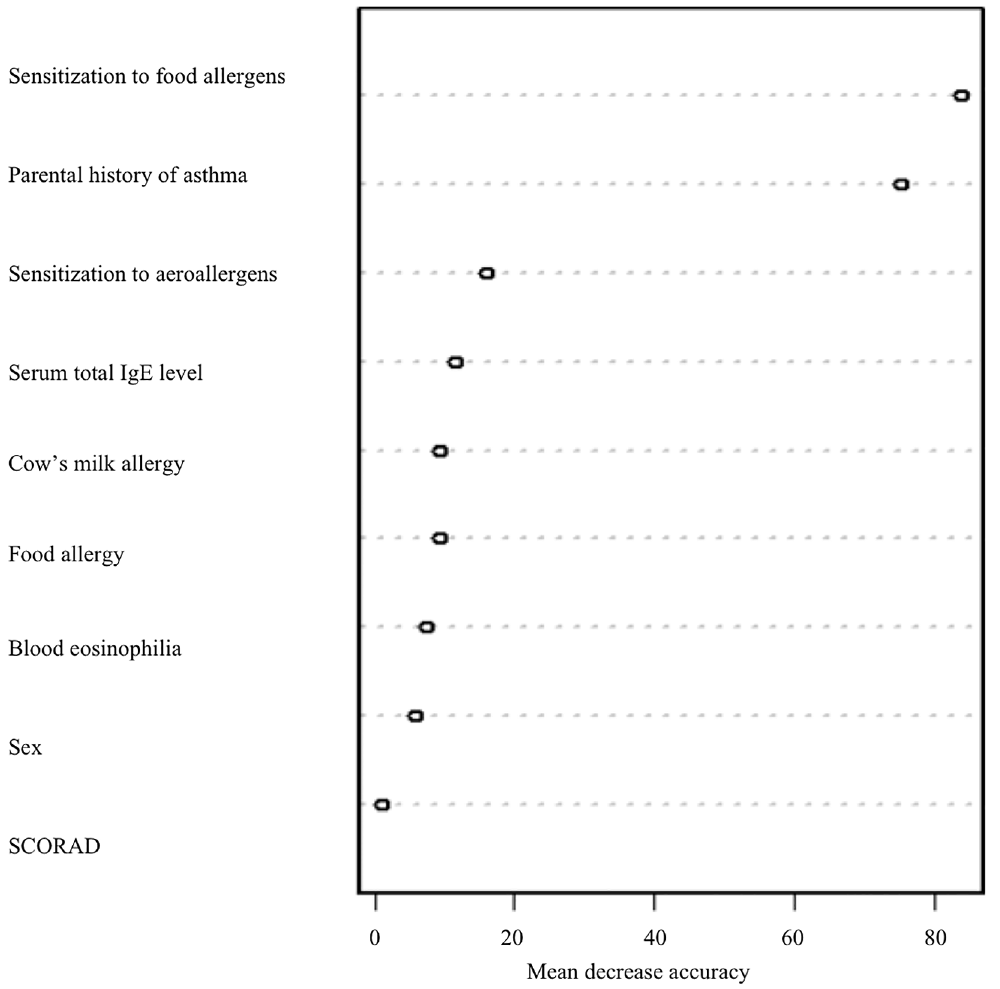
Fig 3. Importance measure (permutation-based mean decrease accuracy) provided by the random forest analysis. The values are not interpretable but the ranking is of interest since a high value of the importance measure is associated with a high predictive power. Sensitization is defined by specific IgE to one or more allergens (cid:1) 0.35 kUI/L. Multiple sensitizations were defined as at least two positive specific IgEs to allergens. Serum total IgE level expressed in kU/L, blood eosinophilia expressed in eosinophils/mm